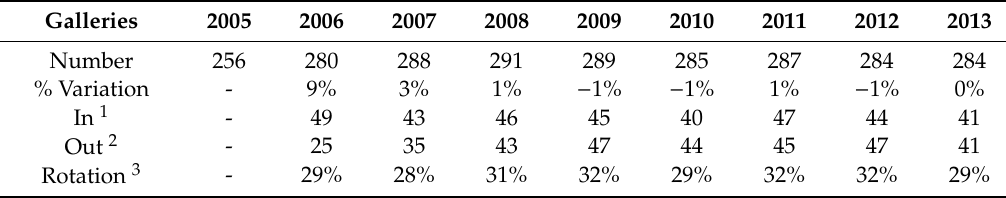
Table 1. Number and rotation of galleries at the Art Basel fair.